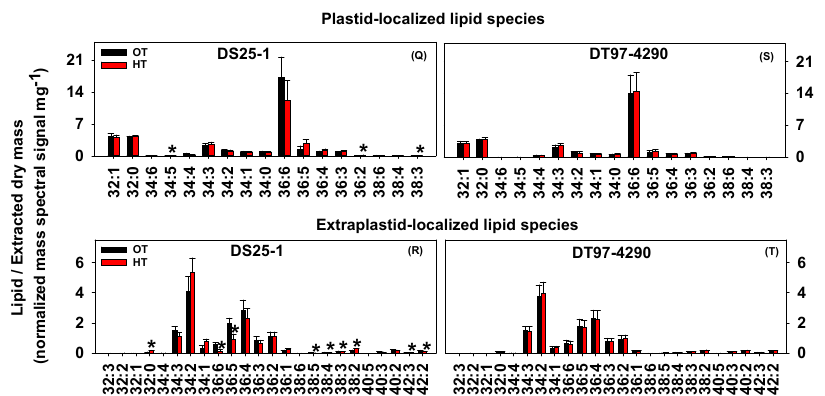
Figure 2. Decrease in the amounts of most unsaturated lipid species (36:6, 36:5, 36:4, 36:3, 34:4, and 34:3 lipids) and increase in the amounts of saturated and less unsaturated lipid species (32:0, 34:1, 34:2, and 36:1 lipids) in the heat-tolerant soybean genotype DS25-1 and absence of these lipid remodeling in the heat-susceptible genotype DT97-4290. Panels A through P show the e ff ects of temperature on plastid-localized (DGDG, MGDG, and PG) and extraplastid-localized (PC, PE, PI, PS, and PA) diacyl lipid molecular species of DS25-1 (left) and DT97-4290 (right). Panel Q through T represent